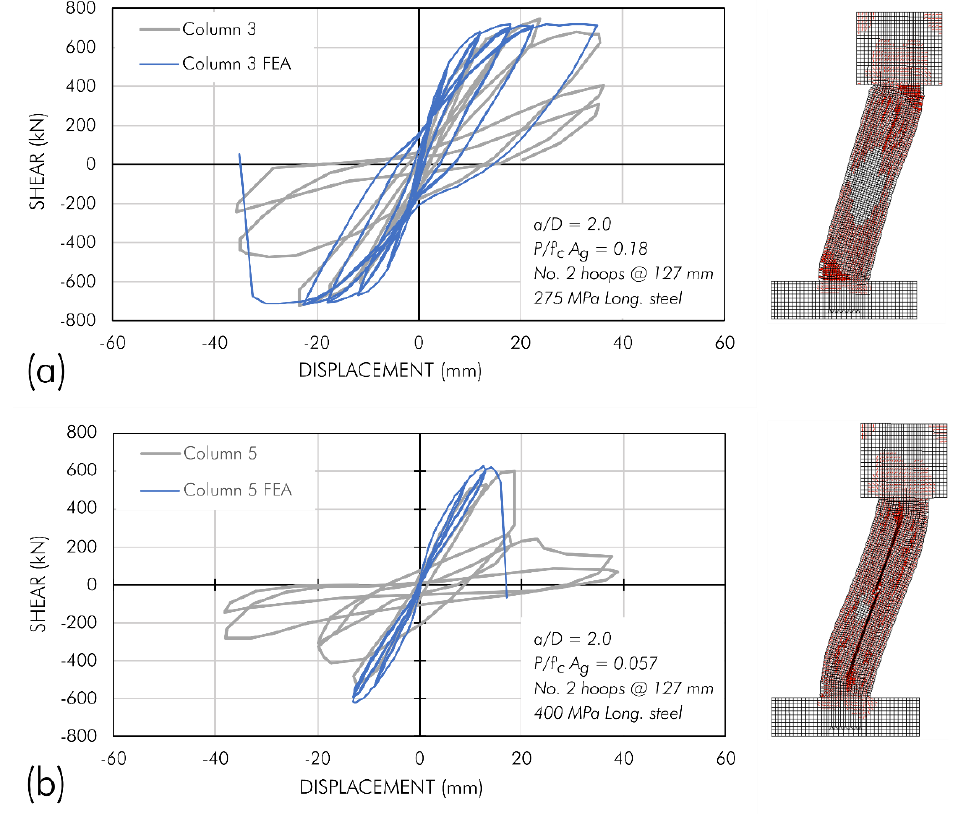
Figure 9. Nonlinear finite element analysis predictions of shear-deflection responses and deflected shapes at failure (20 × magnification) for columns tested by Verma et al. [22]: ( a ) Column 3; ( b ) Column 5.